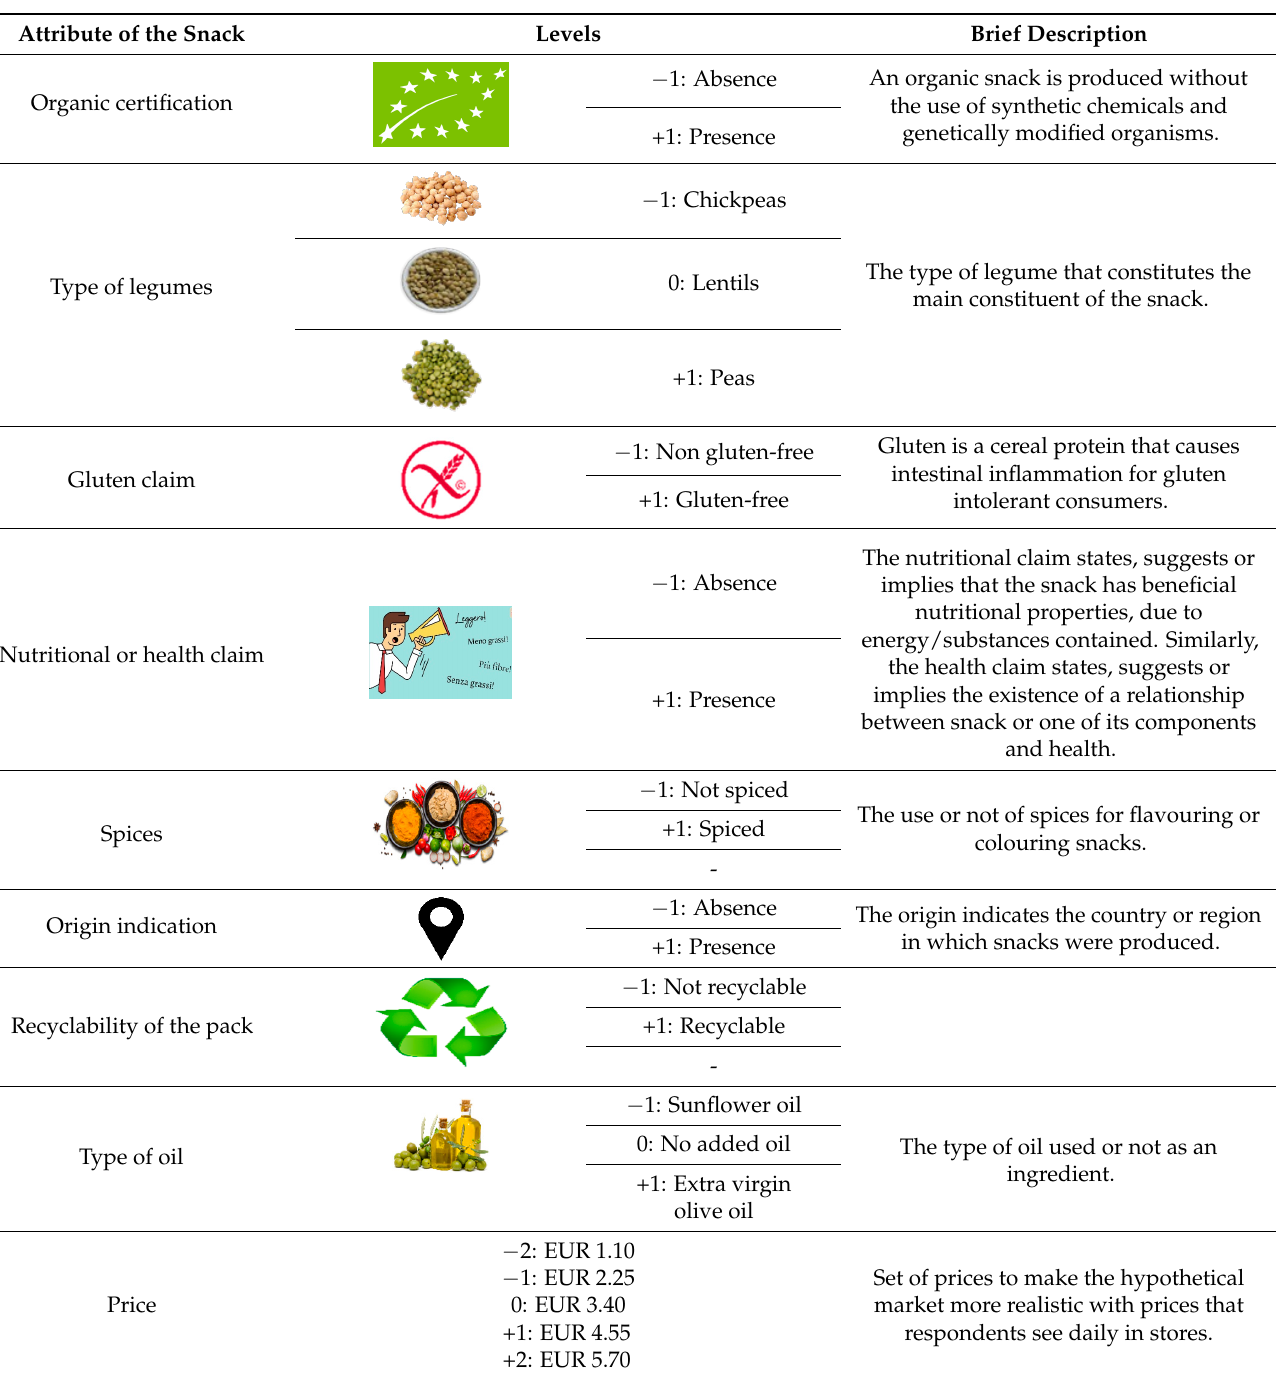
Table 3. Attributes and levels used in our discrete choice experiment.